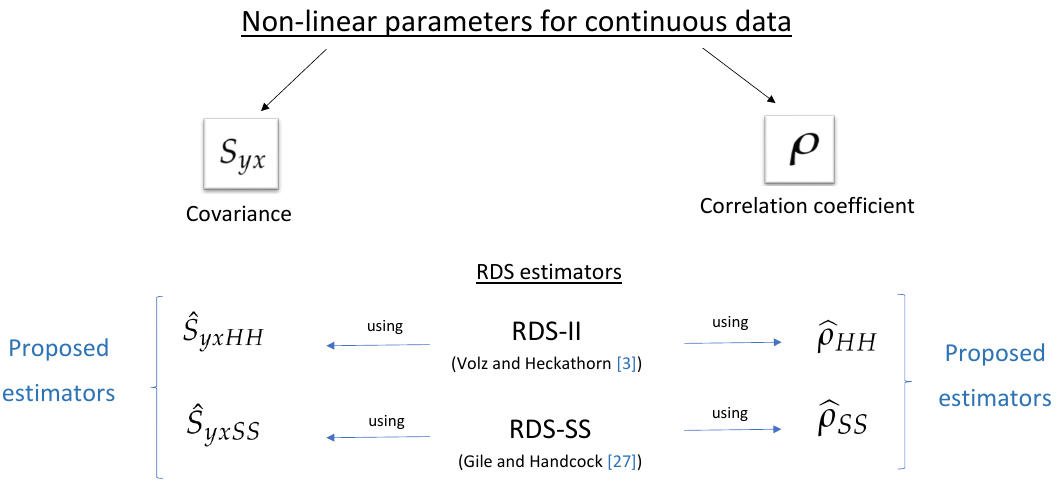
Figure 1. Schematic representation of the proposed